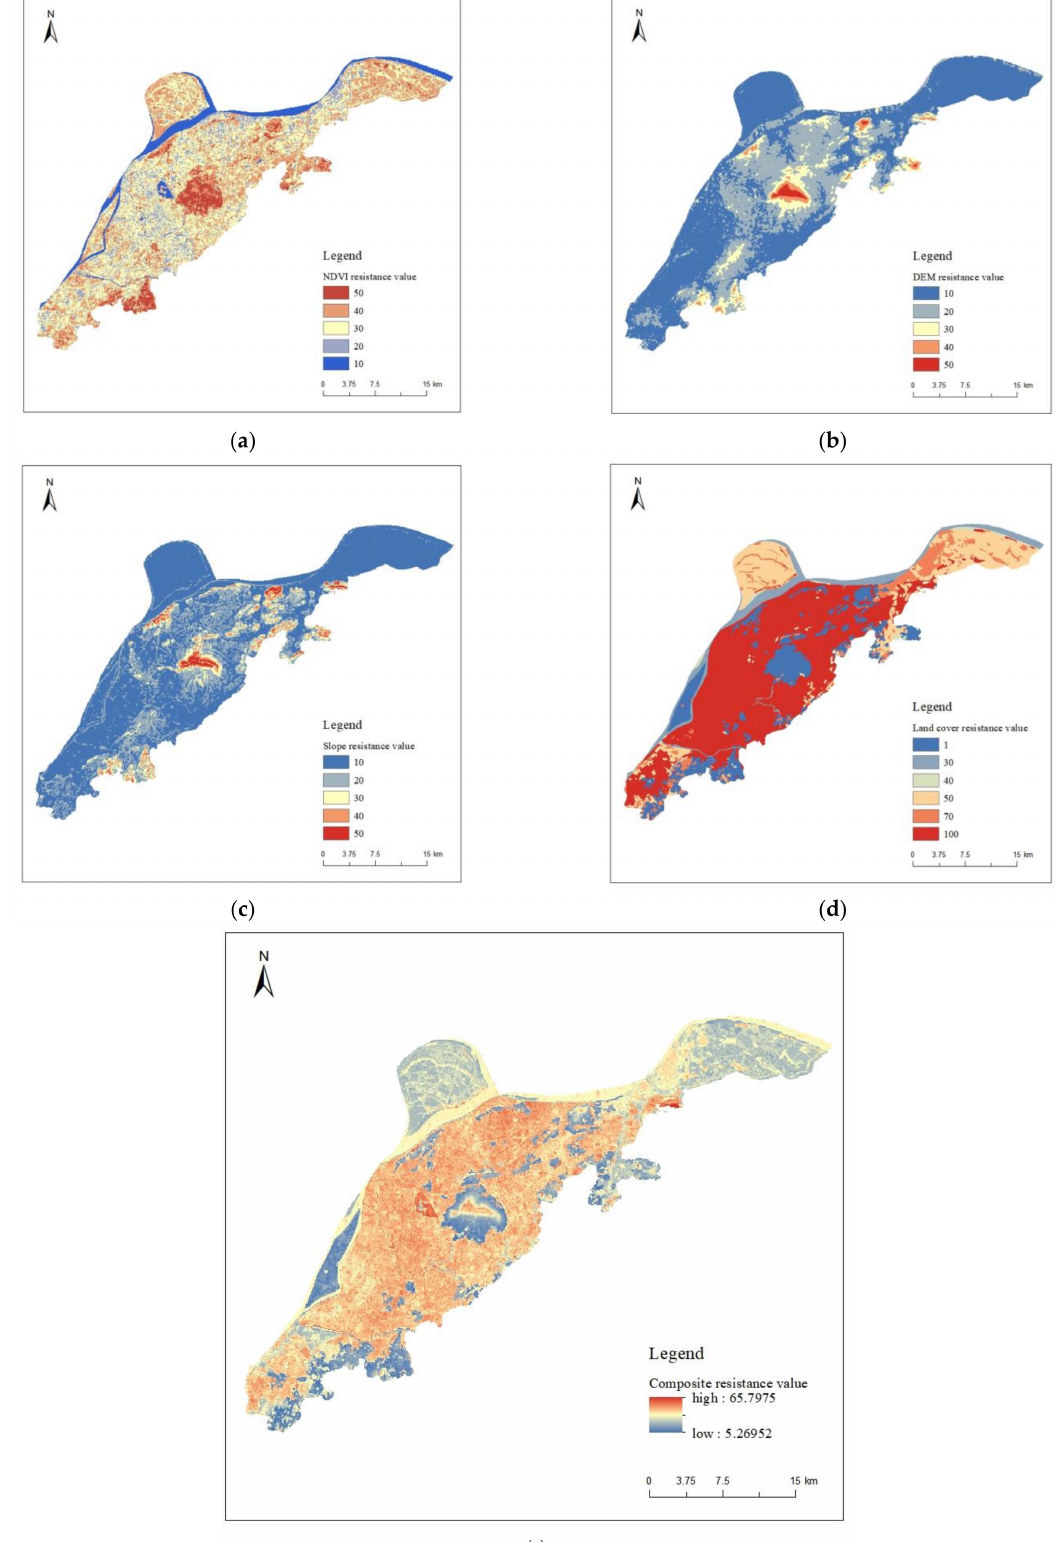
Figure 3. Resistance surface distribution in the experimental area: ( a ) NDVI resistance surface; ( b ) DEM resistance surface; ( c ) slope resistance surface; ( d ) land cover resistance surface; ( e ) composite resistance